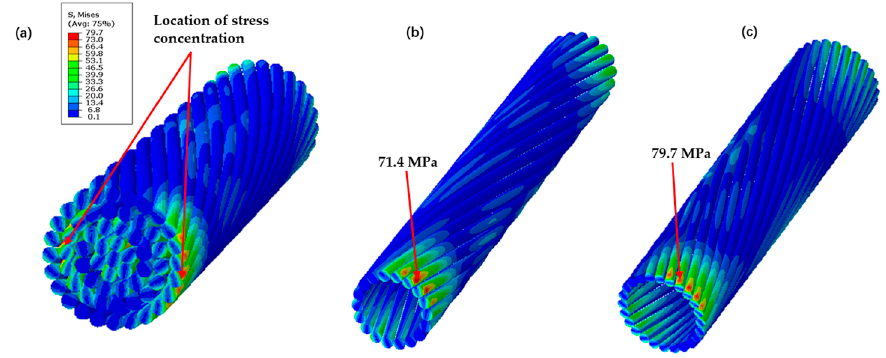
Figure 8. Stress distribution of local model at the outlet of the tension clamp: ( a ) the stress distribution of each layer, ( b ) the stress distribution of the third layer of the conductor, and ( c ) the stress distribution of the outmost conductor.